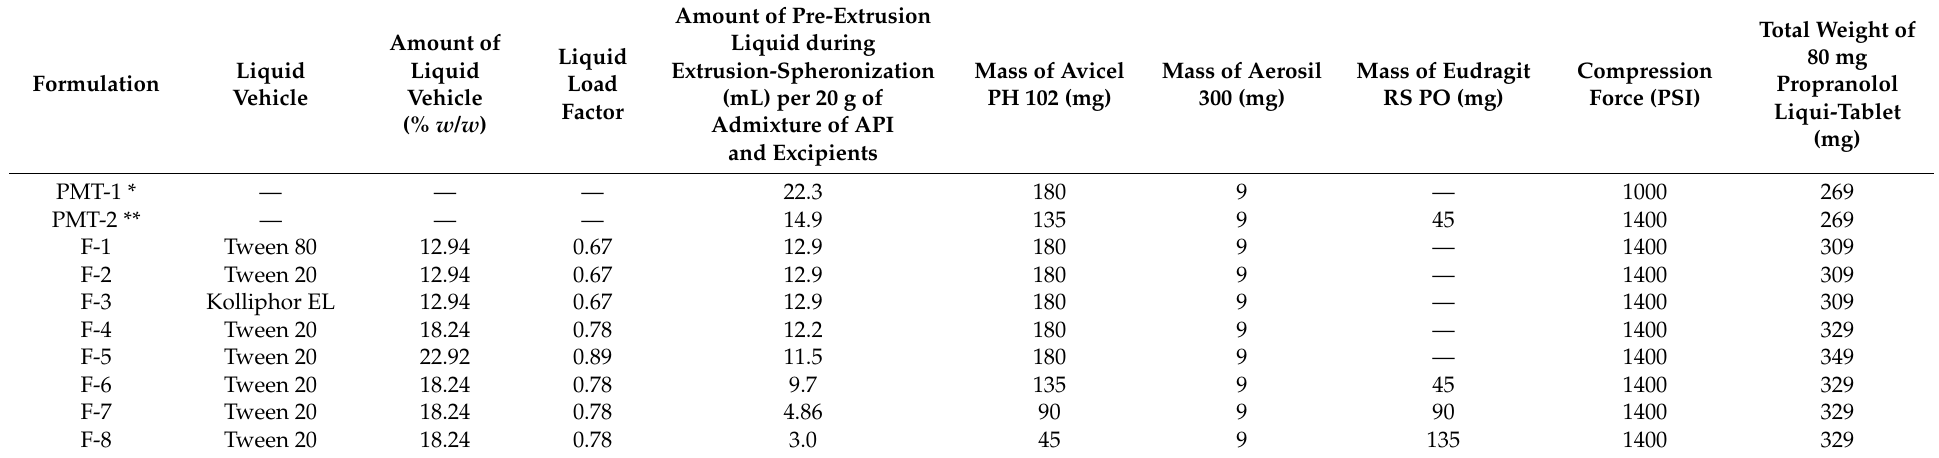
Table 1. Key formulation characteristics of the investigated propranolol SR Liqui-Tablet and physical mixture tablet.